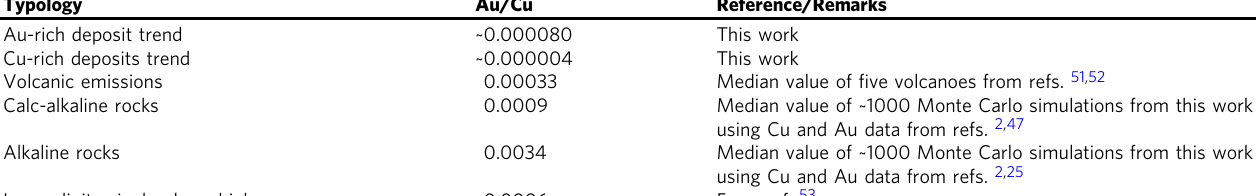
Table 2 Au/Cu values of the porphyry trends and different geological materials. Typology